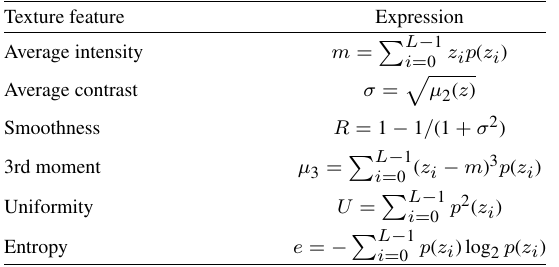
Equations for the 6 texture features to be calculated on each TMA core Texture